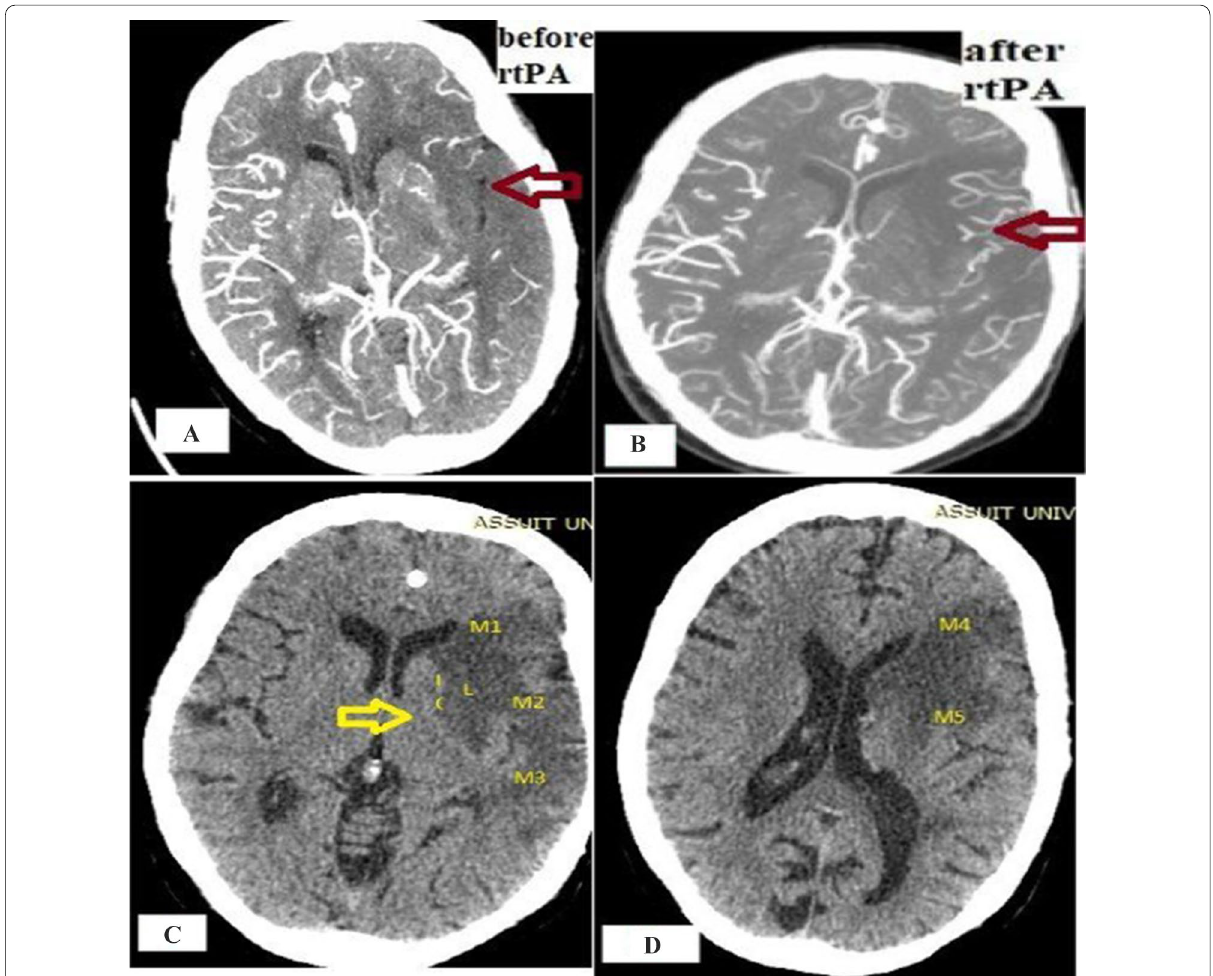
Fig. 4 Patient with mRS 6. A Poor collateral status before rtPA injection. B Poor collateral status after rtPA injection. C , D , Worse ASPECT score